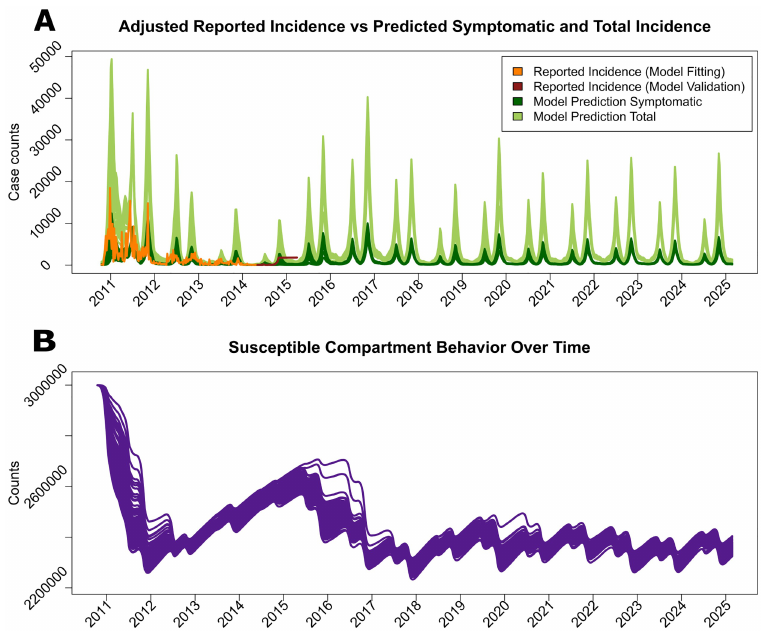
Fig 3. The cholera incidence simulated by the model is presented for the next 10 yearswithout any intervention, along with the illustration of the number of susceptible population members. In the upper panel (A) the observedincidenceof symptomatic cholera cases adjusted for under-reporting (orange),the model-fitted incidenceof symptomatic cases (dark green), both symptomatic and asymptomatic cases (light green) are presented.Incidencedata from October 2010to April 2014were used for estimation, and incidencedata (dark red) from May 2014 until May 2015 were used to illustrate agreement with the model. The number of susceptible individuals (purple)is displayedin the lower panel